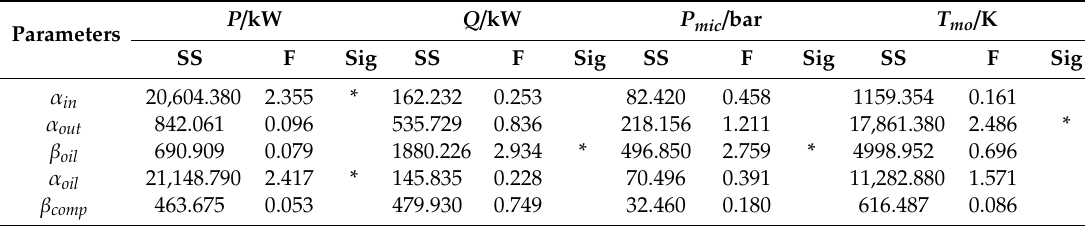
Table 7. Significance test and variance analysis of calculation